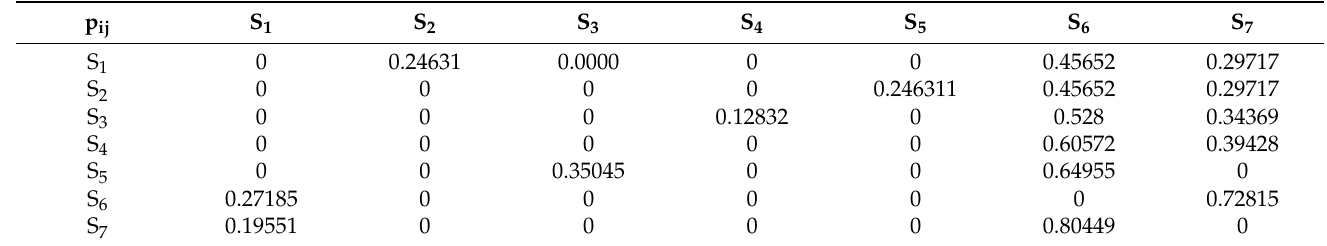
Table 3. Probability of transition between certain exploitation states (own study).